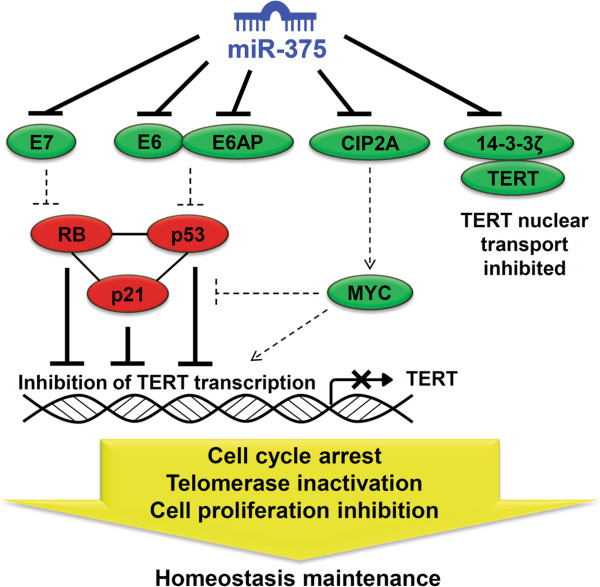
Schematic model of miR-375 as a master regulator in HPV-positive cancers. miR-375-mediated regulation simultaneously suppresses HPV E7, E6, E6AP, CIP2A, and 14-3-3ζ. As a result, the degradation of tumor suppressors p53 and RB is prevented, and p21 protein level increases. miR-375-mediated repression of CIP2A leads to degradation of oncogene MYC and also enhances p21 expression. Increase of transcriptional repressors (p53, p21, RB) and decrease of transcriptional activators (E6 and MYC) promotes TERT transcriptional reduction. miR-375-mediated repression of 14-3-3ζ inhibits nuclear translocation of TERT, thereby contributes to reduce telomerase activity. Overall, high miR-375 levels results in cell cycle arrest, telomerase inactivation and cell proliferation inhibition, which maintain homeostasis of normal epithelial cells. Solid lines represent “activated process” and dotted lines represent “inhibited process.” Molecules repressed or activated by miR-375 are distinguished by green and red colors, respectively.